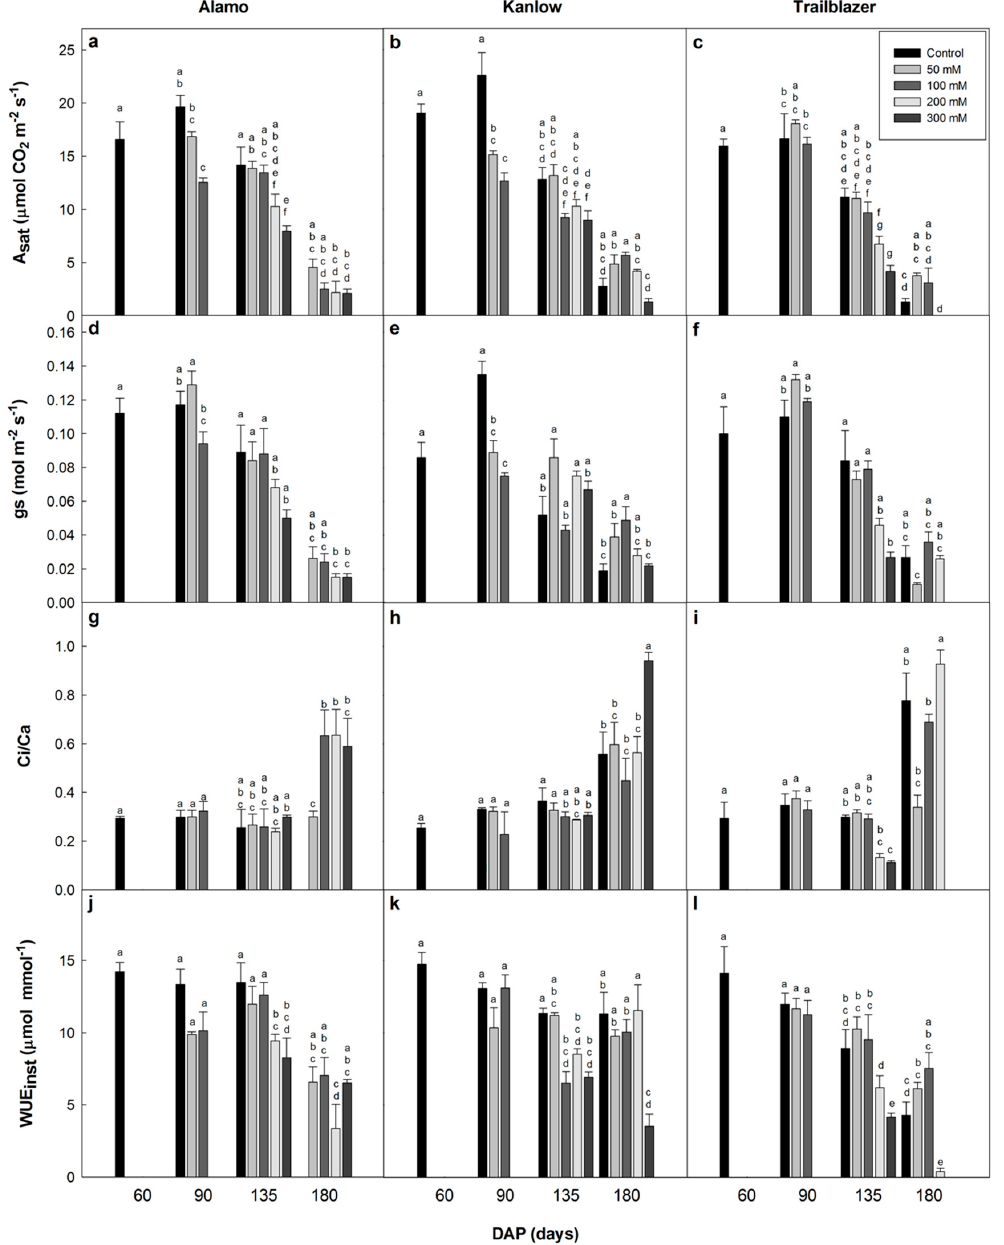
Figure 2. The ( a – c ) CO 2 assimilation rate (A sat ), ( d–f ) stomatal conductance to water vapour (g s ), ( g – i ) ratio of intercellular to external CO 2 concentration (Ci/Ca) and ( j – l ) instantaneous water use efficiency (WUE inst ) of Alamo, Kanlow and Trailblazer genotypes of Panicum virgatum measured at 400 μ mol mol − 1 CO 2 , 2000 μ mol photon m − 2 s − 1 and 25 ± 2 °C for the control, 50, 100, 200 and 300 mM NaCl treatments. The values are the means ± SE ( n = 3–6). Within each DAP, the values that are significantly different are identified with different letters ( p < 0.05).